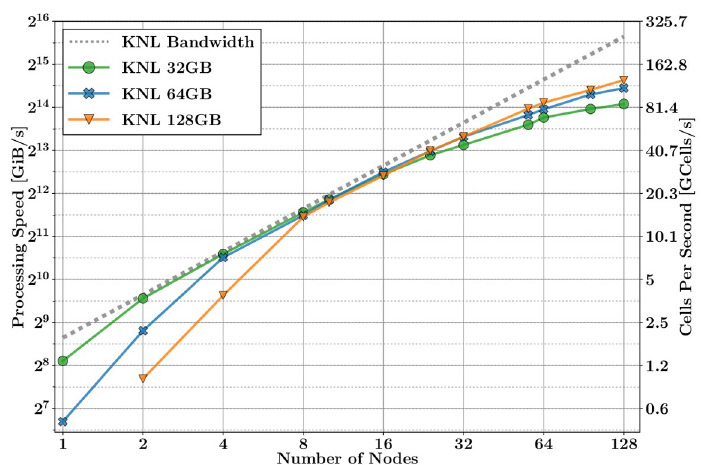
Fig 5. UGRFDTD performance on multiple nodes of Marconi